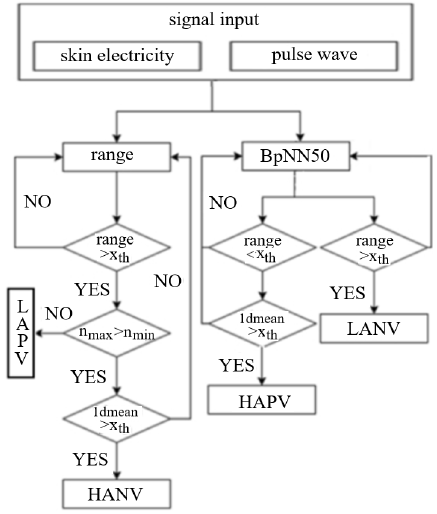
Figure 3. Process of emotion judgment model.